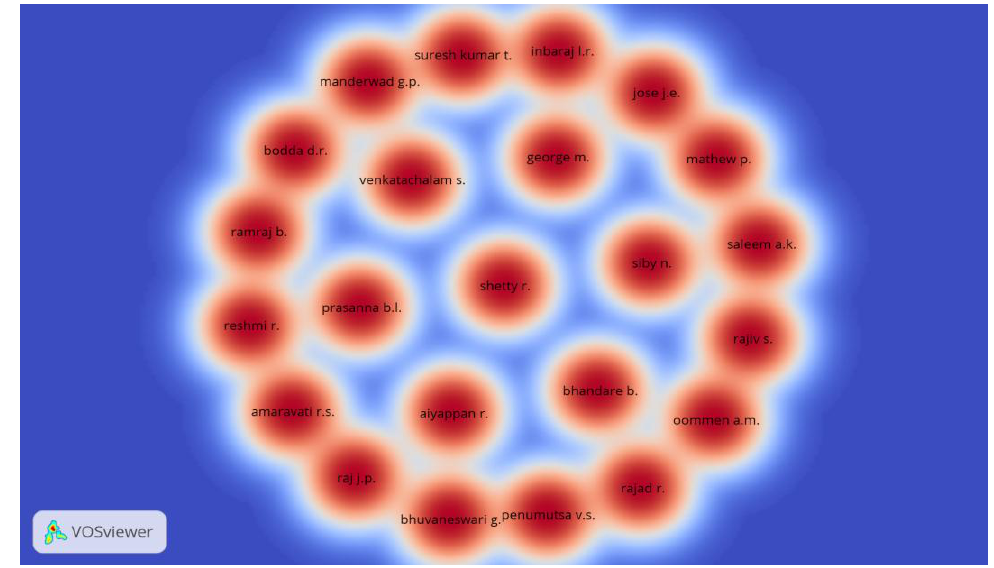
Figure 1 <Visualization of the Authorization